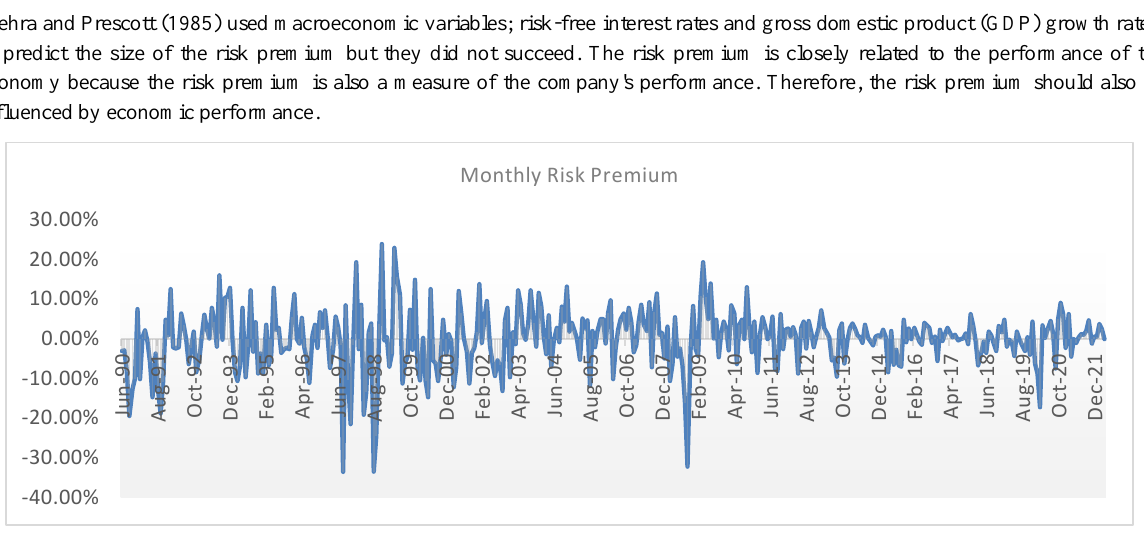
Figure 5: Monthly Risk Premium Period May 1990 – April